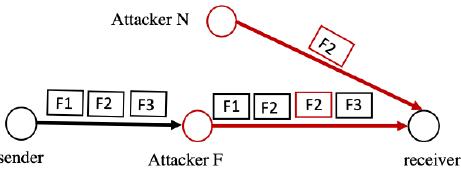
Figure 5. Duplication attack.